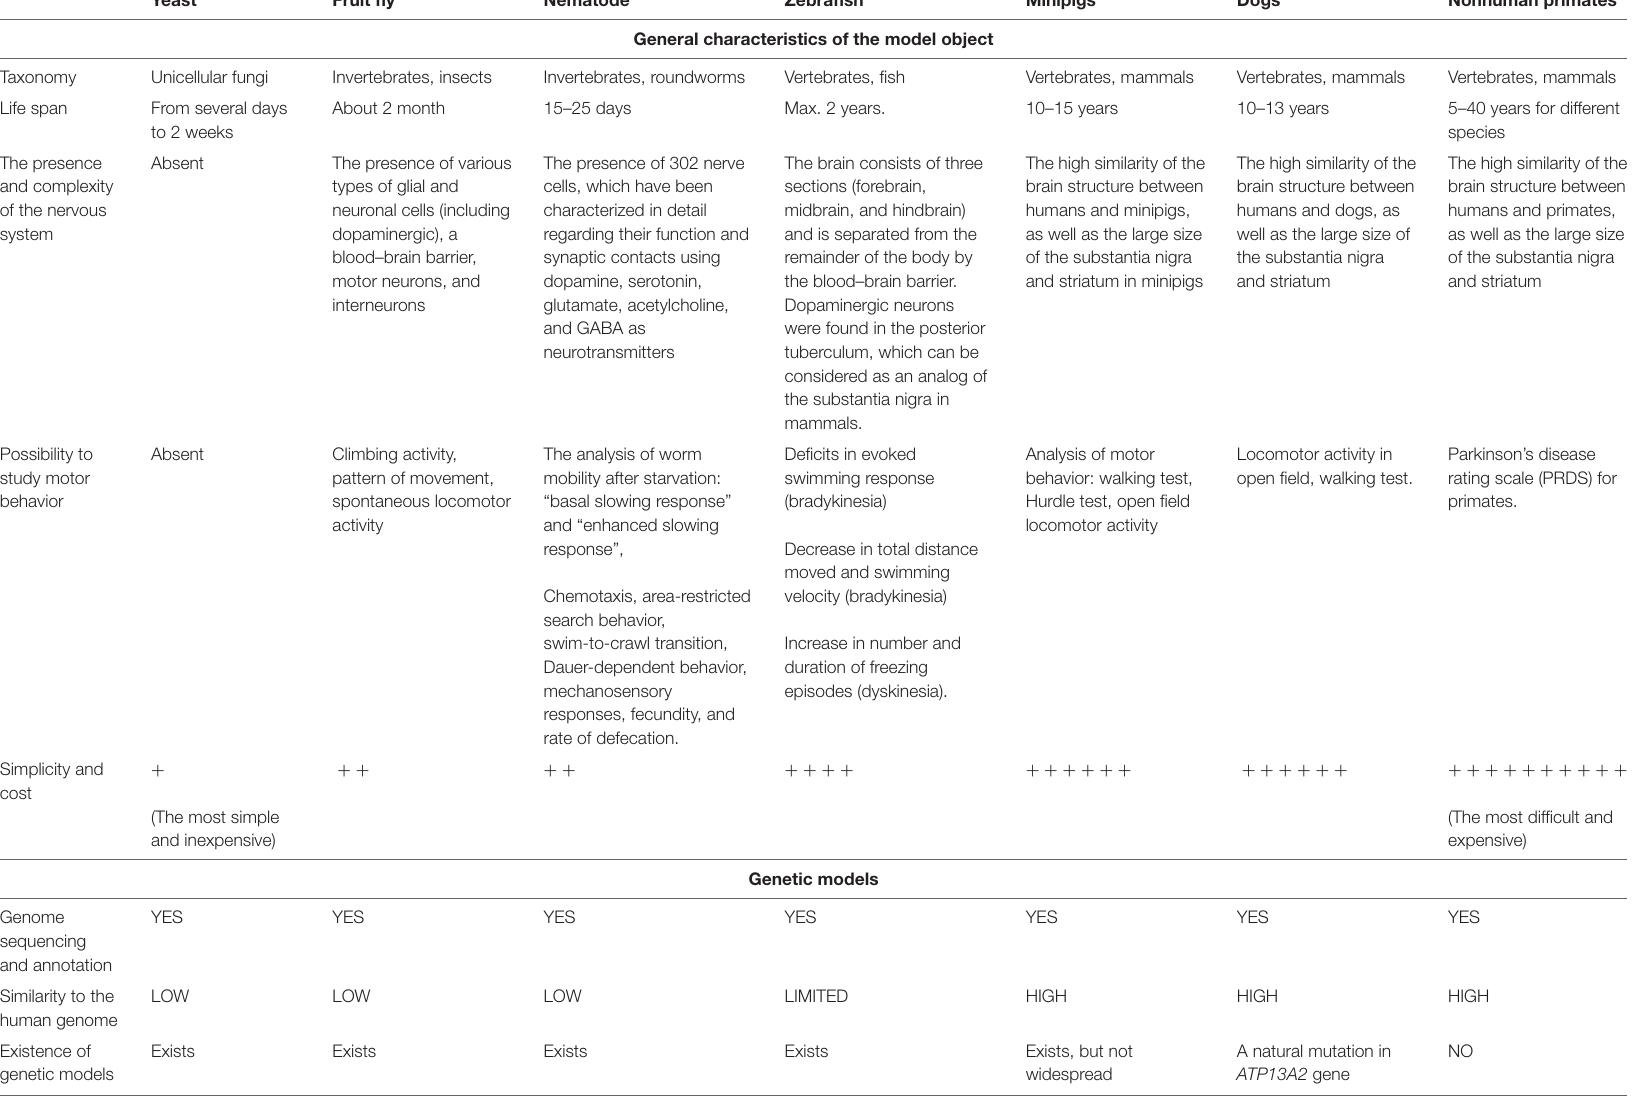
TABLE 1 | Brief characteristics, advantages, and disadvantages of the model